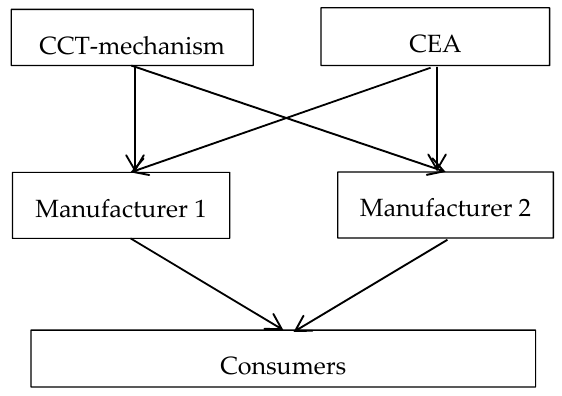
Figure 1. The supply chain structure and decision process.